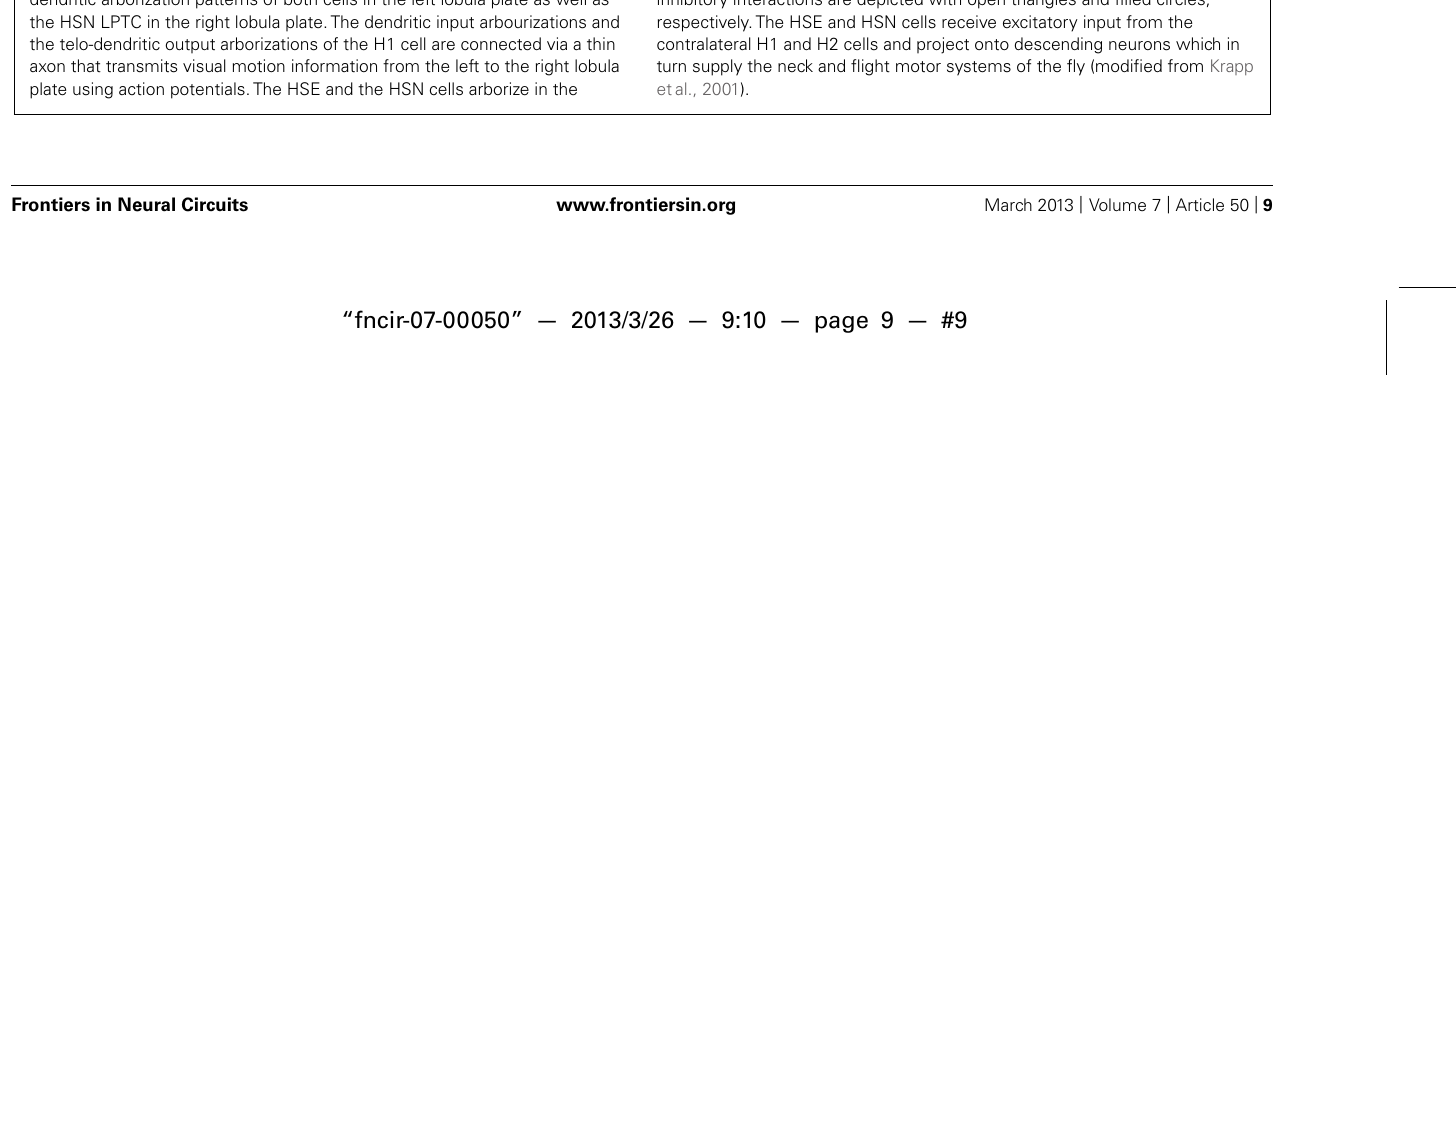
FIGURE 6 | H1 and HSE receptive fields and horizontal network connections. (A) Top row shows monocular and binocular receptive fields of the H1 and the HSE LPTCs, respectively.The insets show the dendritic arborization patterns of both cells in the left lobula plate as well as the HSN LPTC in the right lobula plate.The dendritic input arbourizations and the telo-dendritic output arborizations of the H1 cell are connected via a thin axon that transmits visual motion information from the left to the right lobula plate using action potentials.The HSE and the HSN cells arborize in the